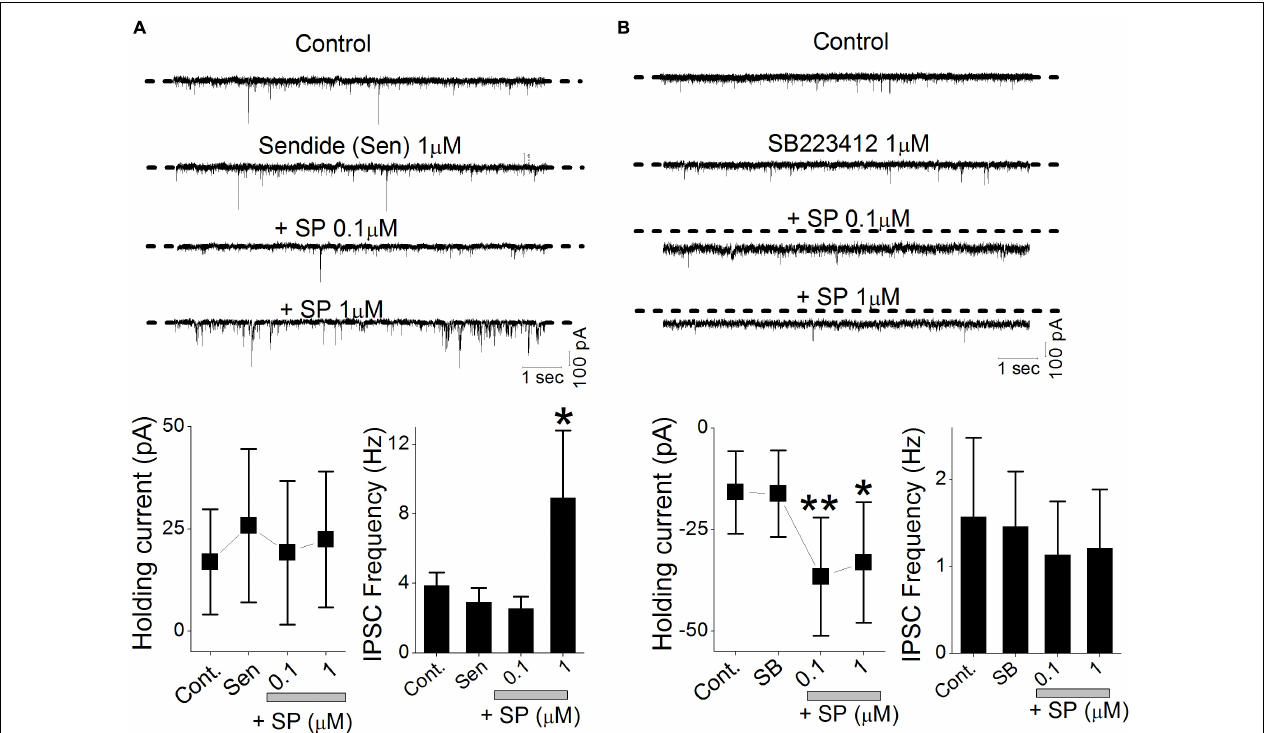
FIGURE 7 | NK receptors affect SP-mediated presynaptic GABA release and postsynaptic holding current. sIPSCs were isolated by recording in the continuous presence of NBQX (20 µ M). (A) Original traces show the effect of sendide alone, sendide + 0.1 µ M SP, and sendide + 1 µ M SP. All traces were obtained from a single neuron. The histograms summarize the holding currents and mean frequencies of the sIPSCs from 6 different neurons. (B) Original traces show the effects of 1 µ M SB223412 (SB), SB + 0.1 µ M SP, and SB + 1 µ M SP. All traces were obtained from a single neuron. The histograms summarize the holding currents and mean frequencies of the sIPSCs from 6 different neurons. Each point and error bar represent the mean ± SDM from 9 different cells. ** P < 0.01, * p < 0.05.